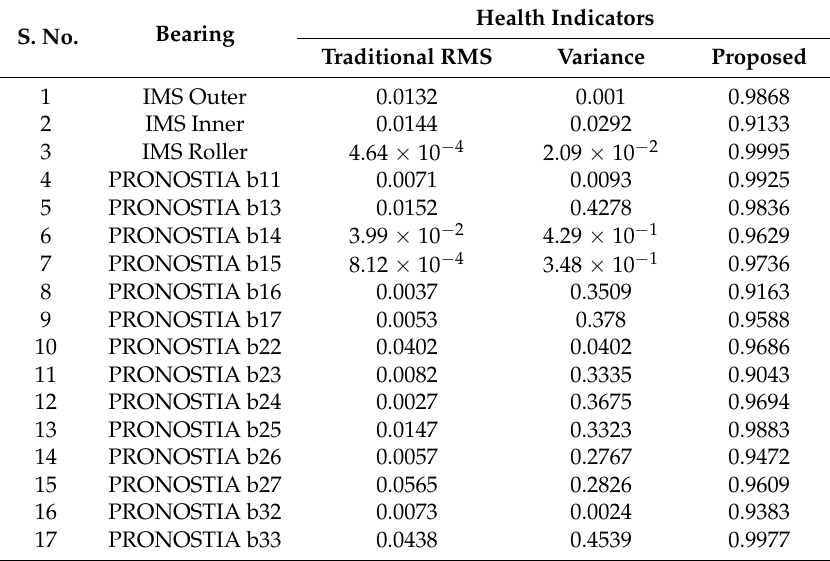
Table 1. Quantitative Evaluation of the Health Indicators using